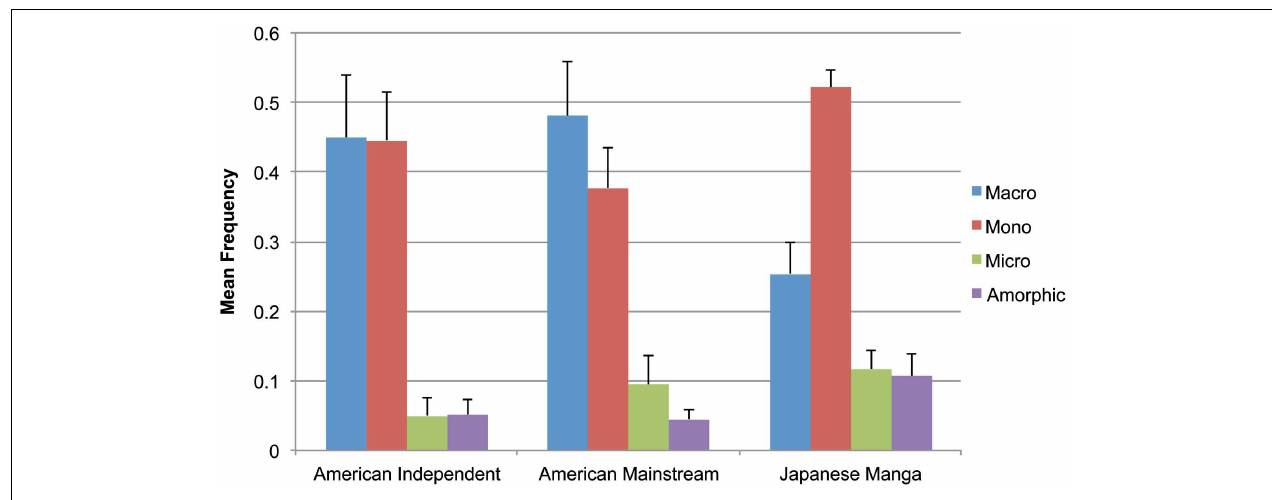
FIGURE 4 | Mean frequency of attentional categories inAmerican Independent and Mainstream comics and Japanese manga.